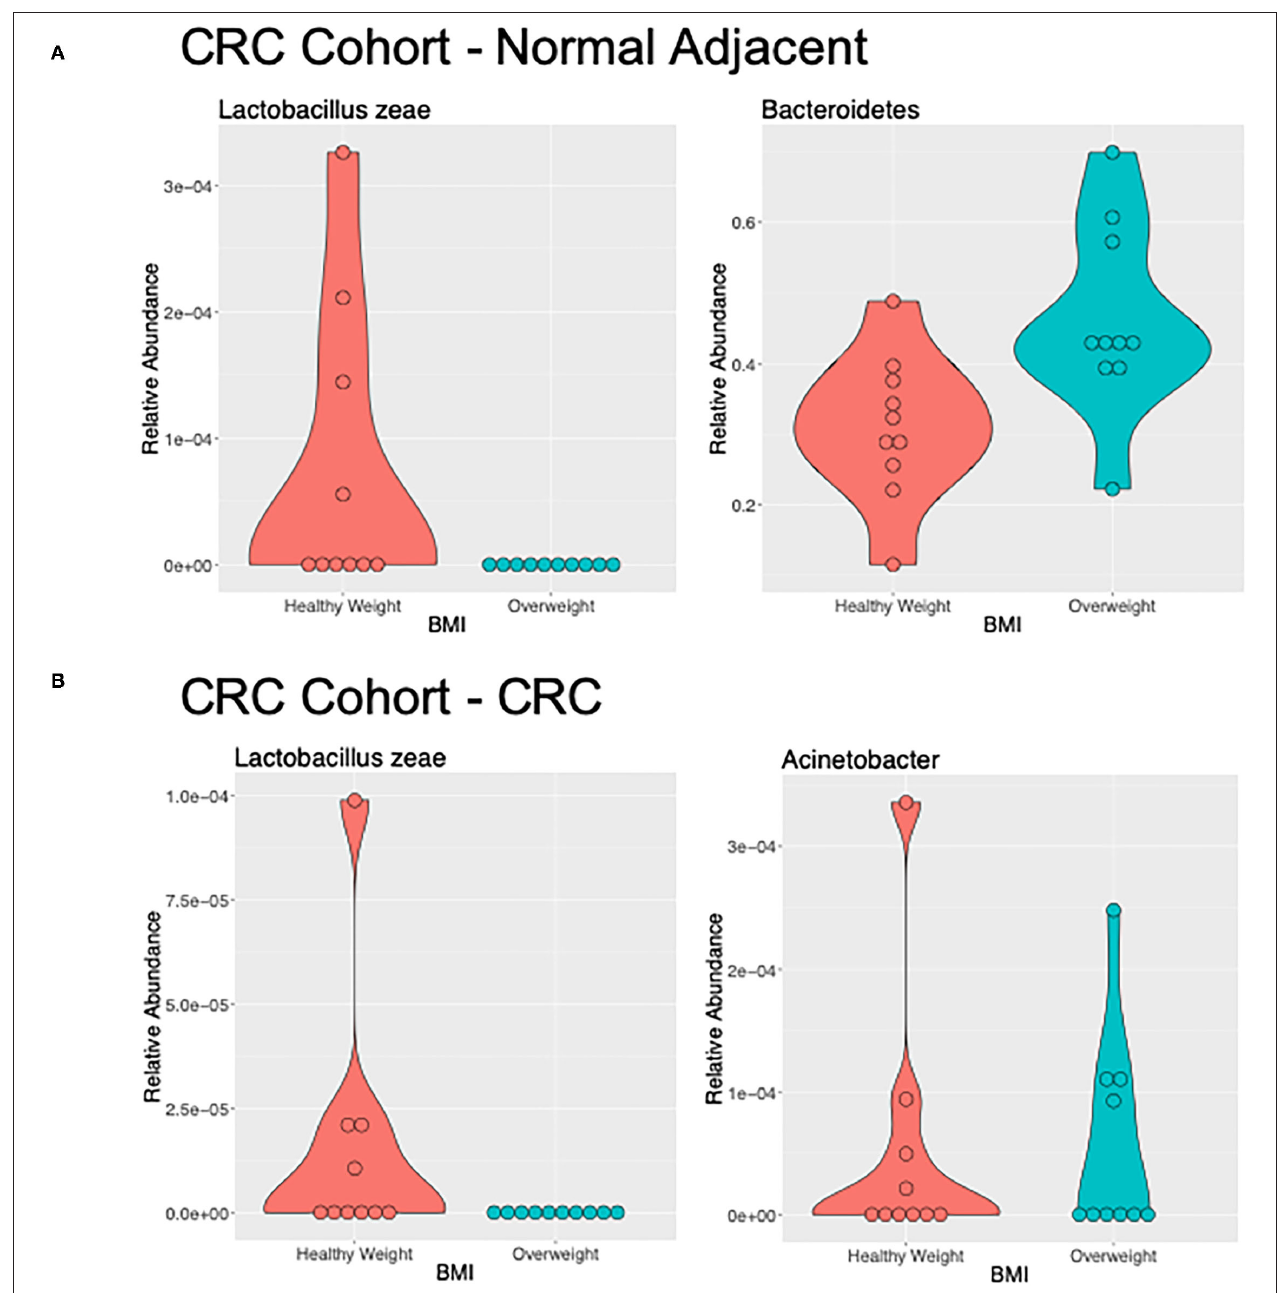
FIGURE 4 | Differentially abundant genera of interest between the samples of healthy weight and overweight patient from (A) adjacent normal mucosa samples from patients with CRC, and (B) CRC samples by LefSe (LDA > 2).